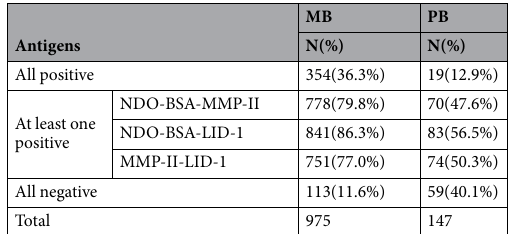
Table 3. Combination of different antigens to detect antileprosy antibodies in leprosy